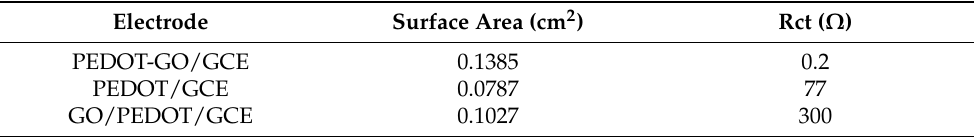
Table 1. Surface area and charge transfer resistance (R ct ) of various electrodes.